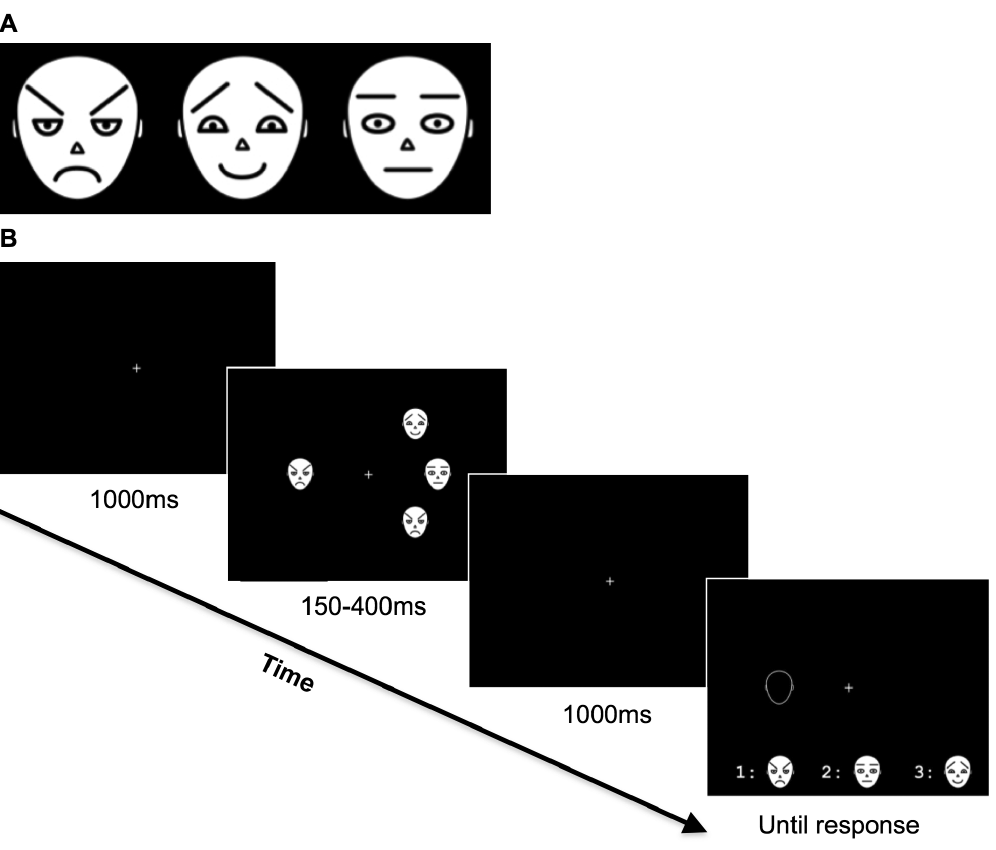
Figure 1. The three emotional expressions of the schematic faces used in the experiments, i.e. Angry, Happy and Neutral faces (Panel A), and an example of the sequence of events in each trial in experiment 1 (Panel B).